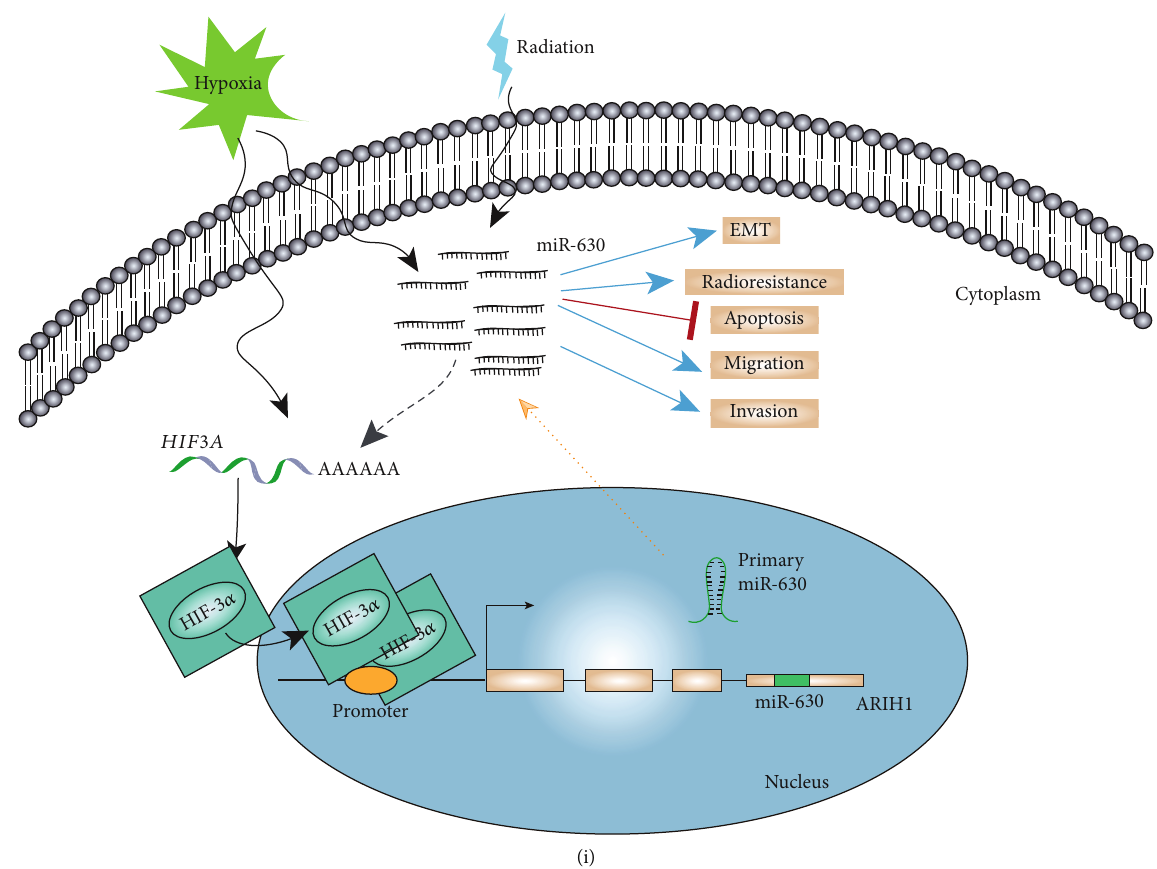
Figure 6: E ff ects of miR-630 on migration and invasion of HeLa cell line and miR-630 promoted HeLa metastasis is mediated by the EMT. (a) Wound-healing assay was performed to compare the migratory capabilities of HeLa, HeLa-virus control, and HeLa-miR-630-inhibitor cells. ∗ p < 0 : 05 . The graph shows the quanti fi cation of migration rates analyzed in HeLa, HeLa-virus control, HeLa-miR-630, and HeLa- miR-630-inhibitor cells, respectively. (b, c) Representative invasion images of HeLa, HeLa-virus control, HeLa-miR-630, and HeLa-miR- 630-inhibitor cells by transwell invasion assay. The right graph shows the quanti fi cation of invasion numbers analyzed in four cells. (d) Heat map plot showed the expression level changes of miR-630 targets that are transcription factors related to EMT. (e) Bar plot showed the RT-qPCR results of transcription factor EP300 upon miR-630 overexpression and knockdown. (f) The morphology of HeLa, HeLa- virus control, HeLa-miR-630, and HeLa-miR-630-inhibitor cells. Note: (A) cell space became wide; (B) spindle-cell morphology formed; (C) pseudopodia were stretched out. Scale bar = 100 . (g) WB was performed to analyze the expression of EMT makers. (h) Cellular staining showed the cytokeratin distribution in the HeLa cells. (i) Working model showed the HIF3A-miR-630 regulatory loop in HeLa